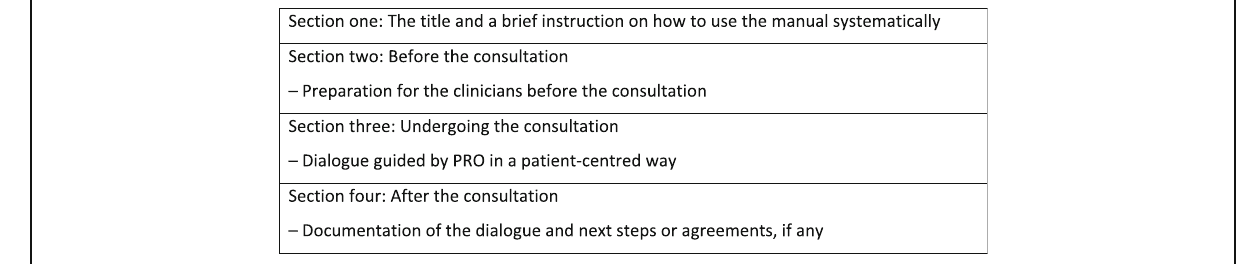
Fig. 2 The main content of each section in the